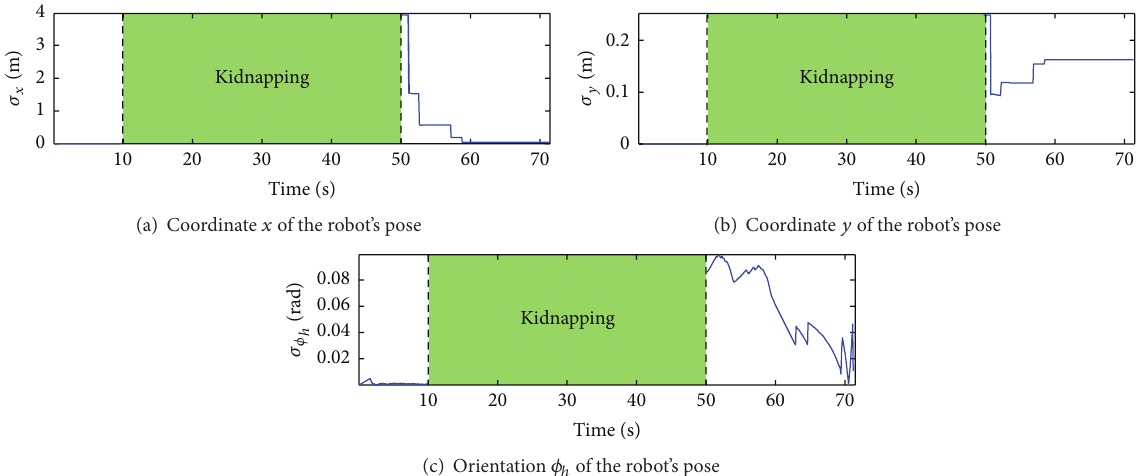
Figure 8: Uncertainty versus time: convergence of the localization system when the robot is kidnapped during an interval of time (green